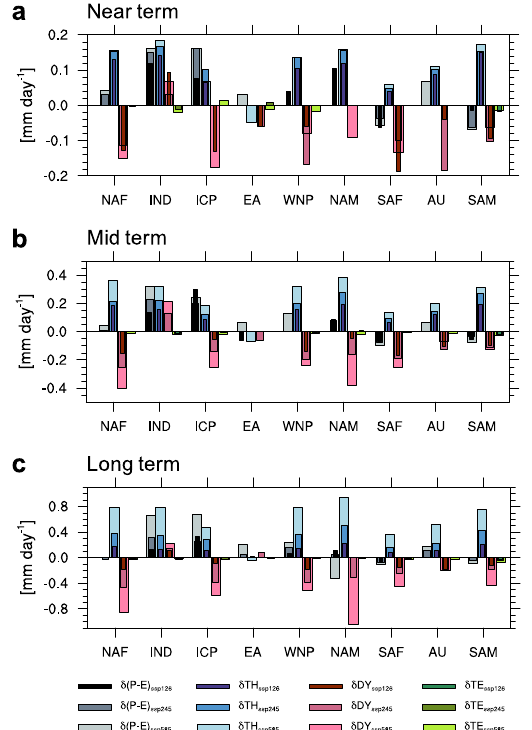
Fig. 5 Regionally averaged future changes of each term of the moisture budget equation. a – c Future changes of precipitation minus evaporation (P − E; black), thermodynamic (TH; blue), dynamic (DY; red), and transient (TE; green) terms in the a near term (2021 – 2040), b mid term (2041 – 2060), and c long term (2081 – 2100) across regional monsoon regions. The width of the bar shows the future scenarios: SSP126 (narrow), SSP245 (middle), and SSP585 (wide). The shown bars indicate that more than two-thirds of the models agree on the sign of the